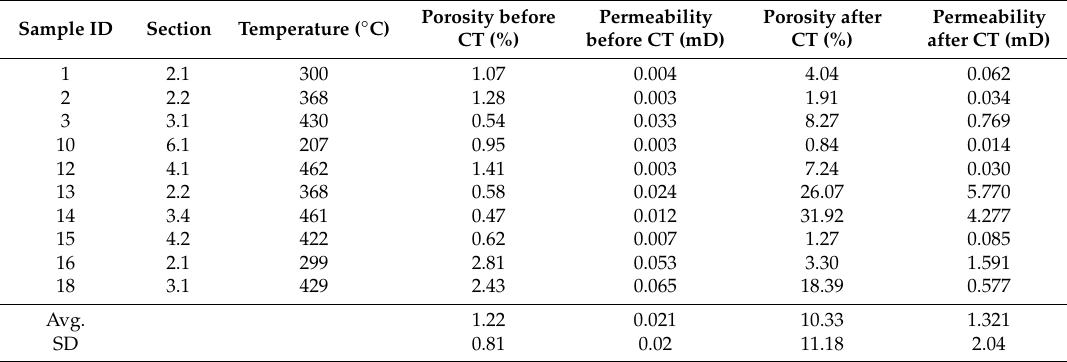
Table 4. Gas porosity and permeability before and after the combustion.